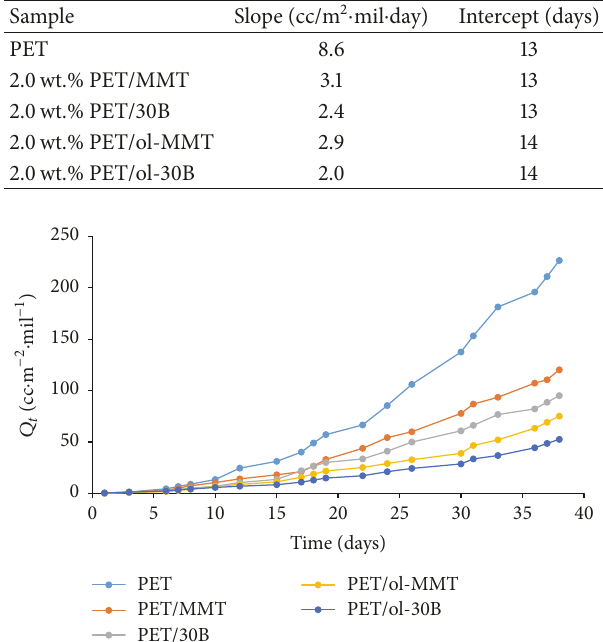
Table 4: Slope and intercepts of cumulative plots. Sample